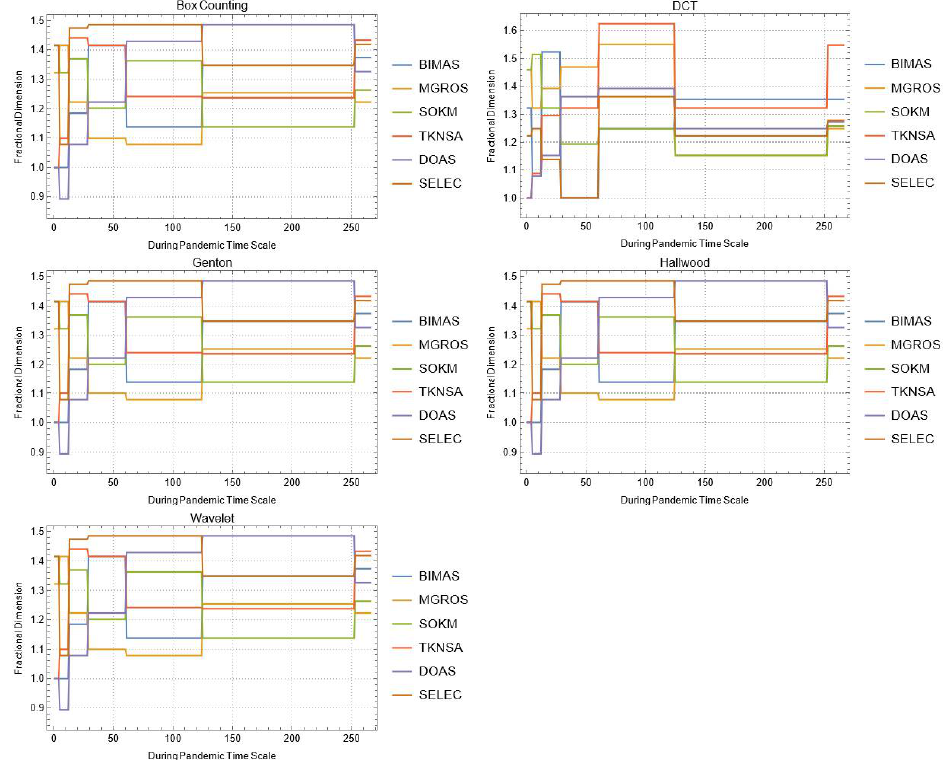
Figure A13. Daily changes of fractal dimensions during the pandemic (wholesale–retail).